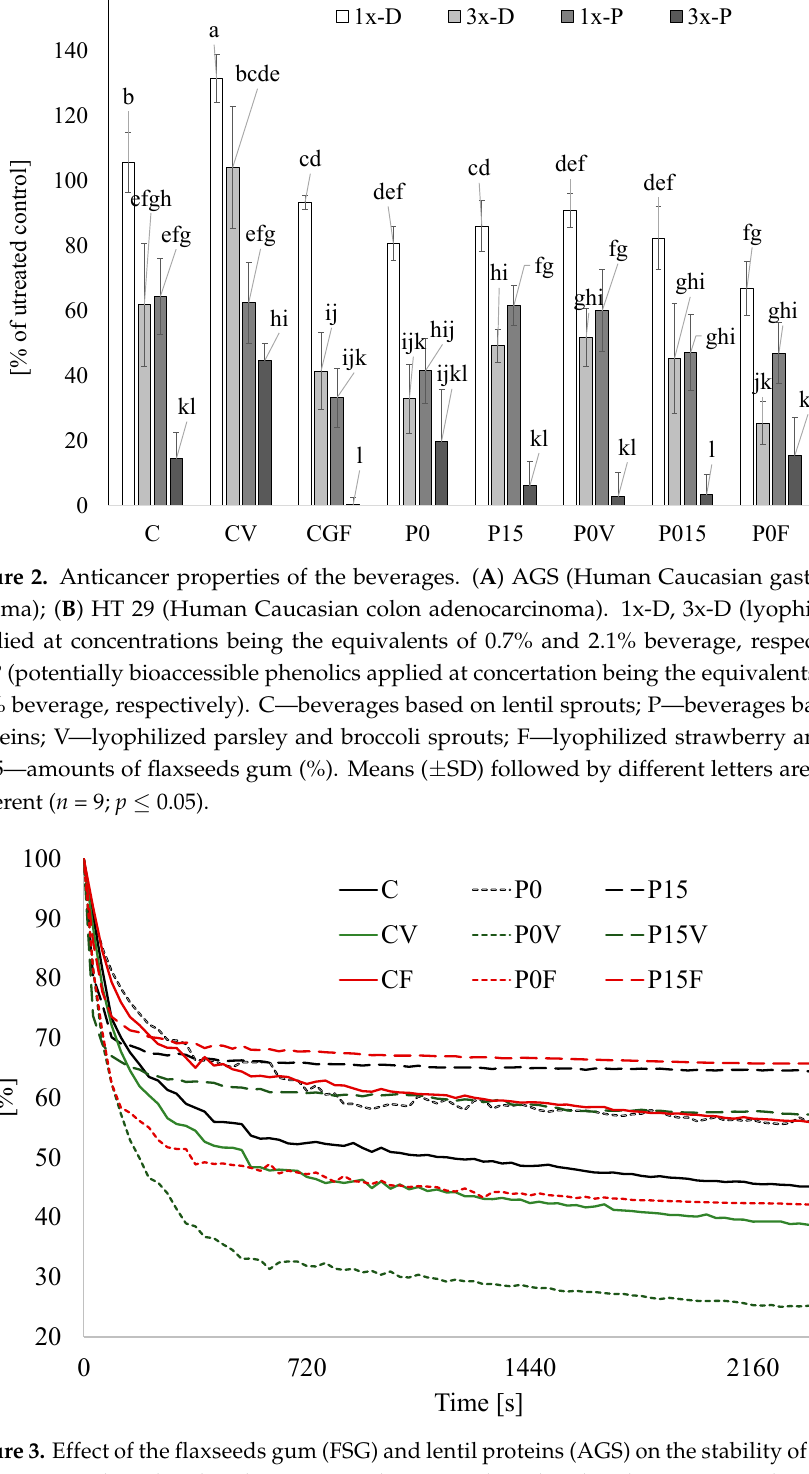
Figure 3. Effect of the flaxseeds gum (FSG) and lentil proteins (AGS) on the stability of the beverage. C—beverages based on lentil sprouts; P—beverages based on lentil proteins; V—lyophilized parsley and broccoli sprouts; F—lyophilized strawberry and raspberry; 0–15—amounts of flaxseeds gum (%).